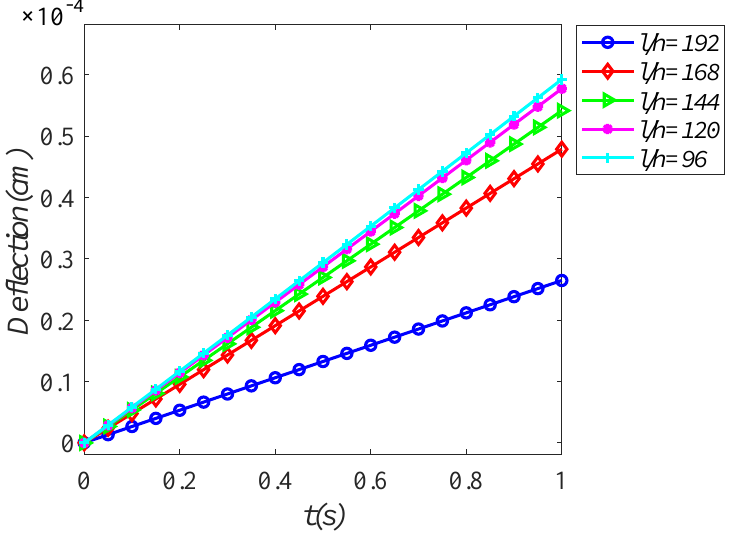
Figure 4. Deflection of micro-beams of different length scale